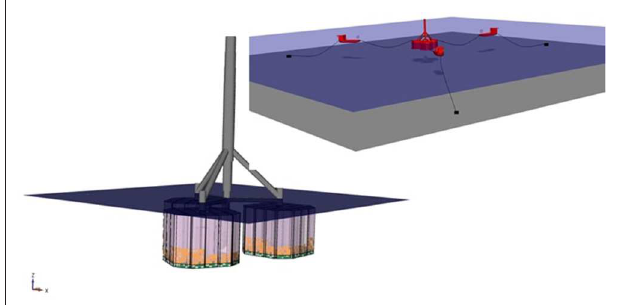
FIGURE 11 | Installation configuration and ballasting process.